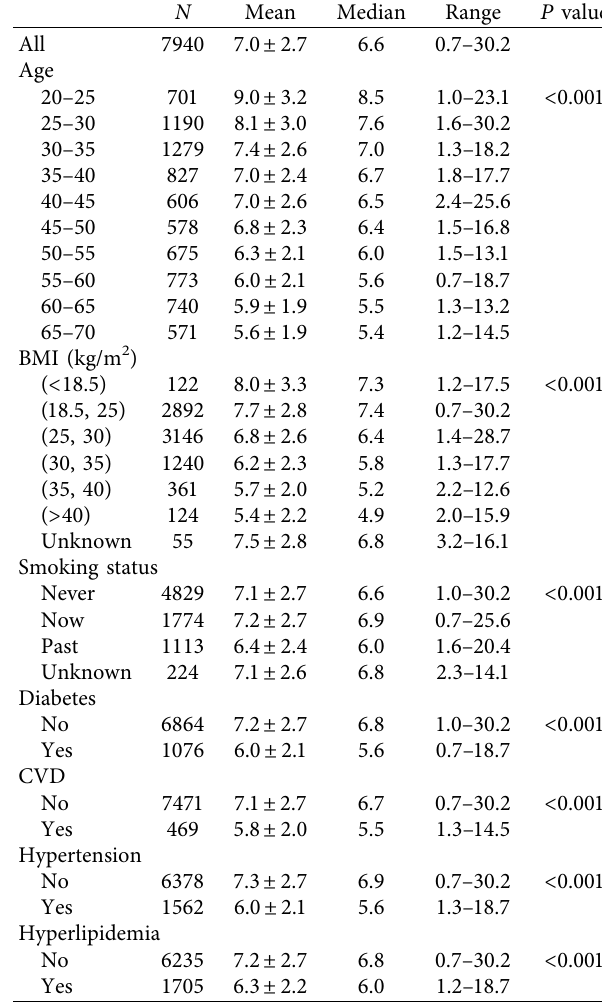
Table 2: Bioavailable testosterone levels stratified by age, BMI, smoking status, diabetes, CVD, hypertension, and